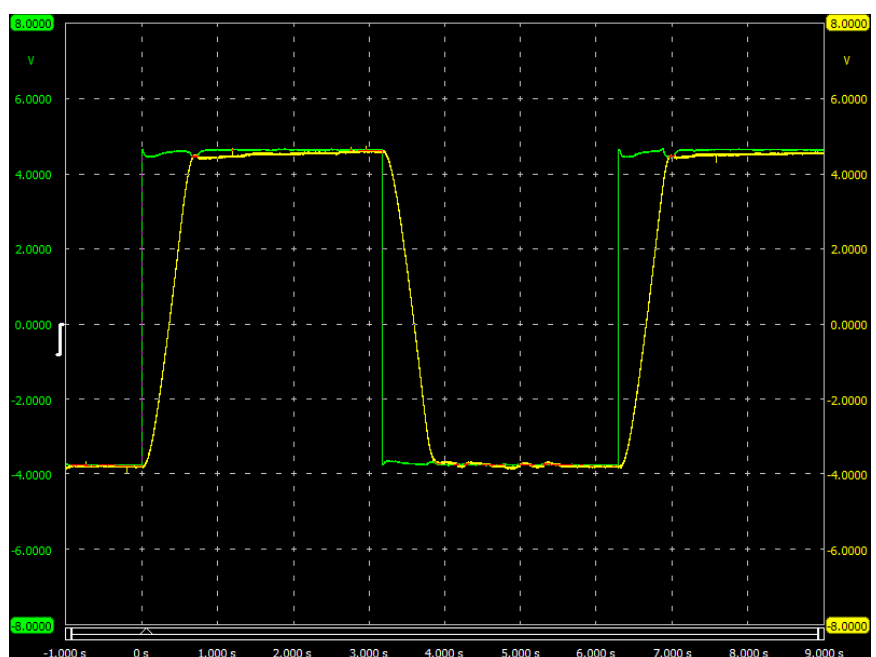
Fig. 11. Output response without ringing by using velocity feedback (microcontroller-based controller, Kp =25 and Kv =2)